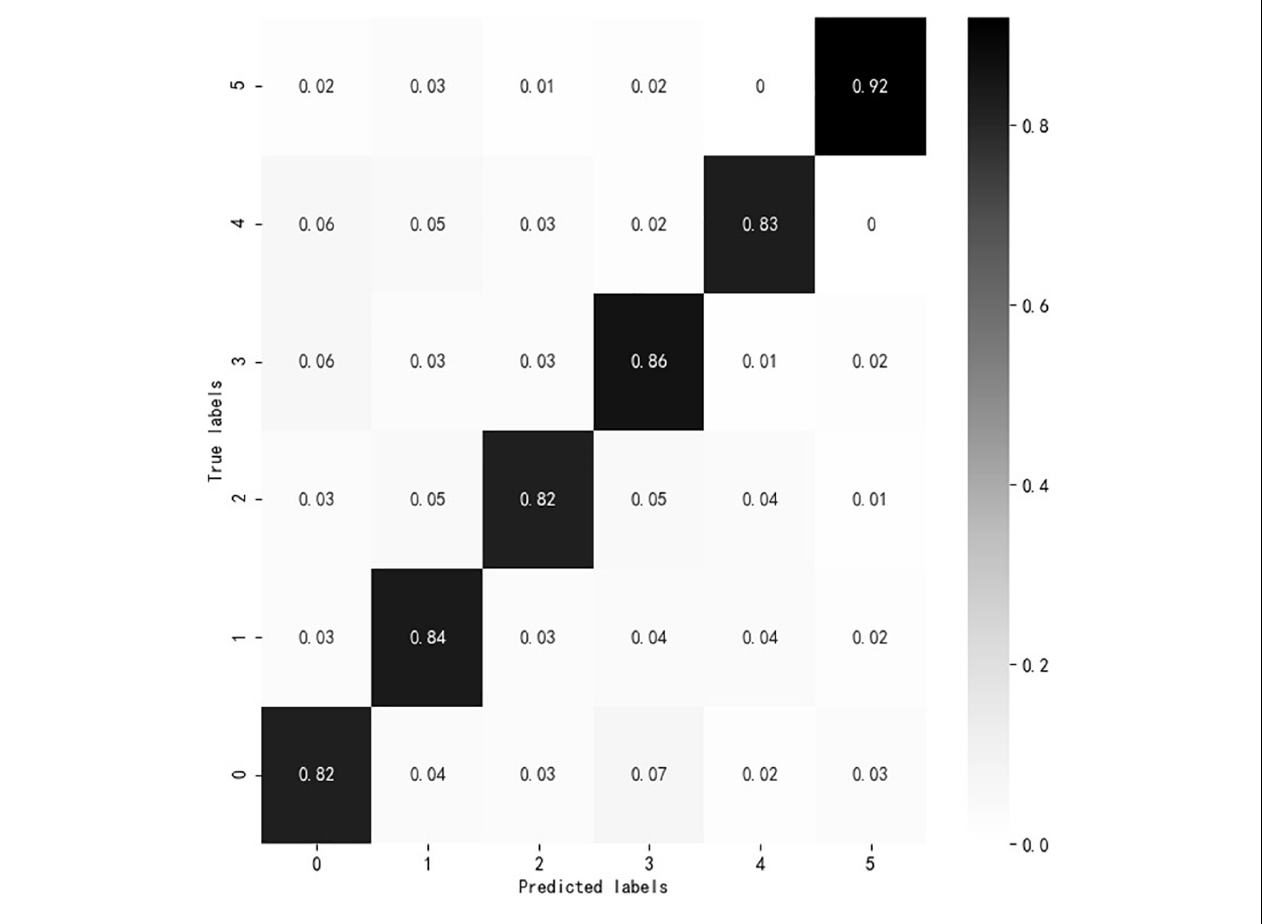
FIGURE 8 | Confusion matrix analysis